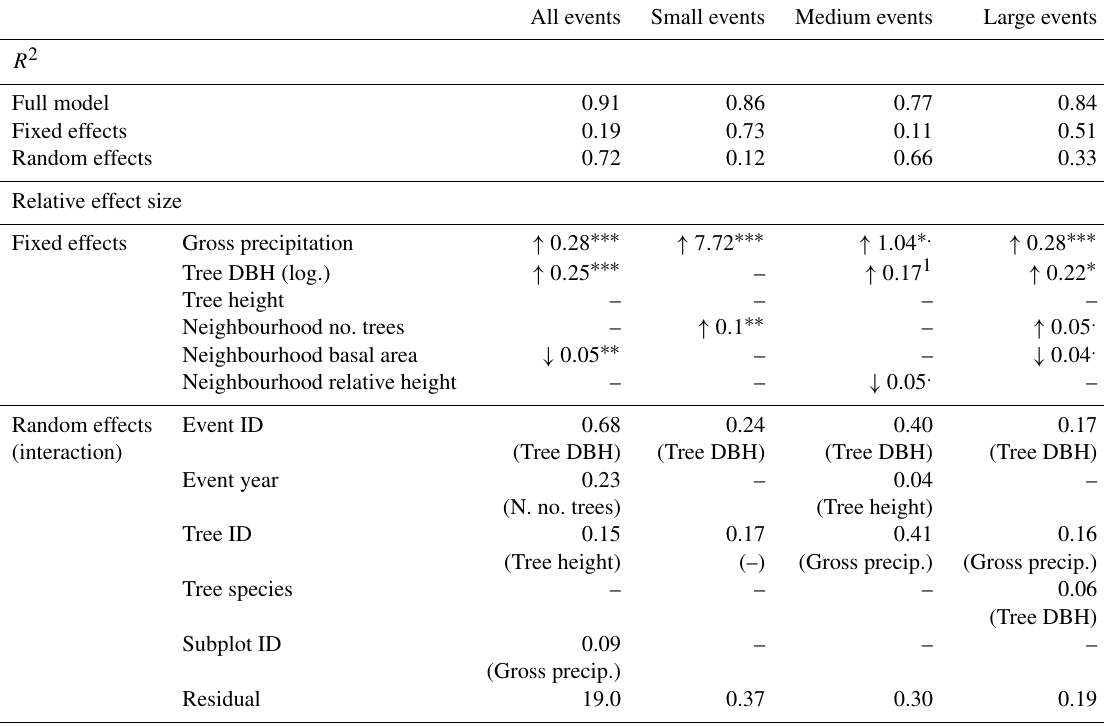
Table 4. Results of the linear mixed effects models for individual tree stemflow yield: slope estimates and significance levels of significant fixed effects, standard deviations of random effects and their interacting fixed effects (random slopes). The four models include (i) all precipitation events, (ii) small precipitations events with less than 5mm of rainfall, (iii) medium precipitation events with between 3 and 10mm of rainfall and (iv) large precipitation events with more than 10mm of rainfall. Pseudo- R 2 values are given for each full model (fixed and random effects), for the fixed effects model separately and for the random effects model separately. Note that data were scaled before model